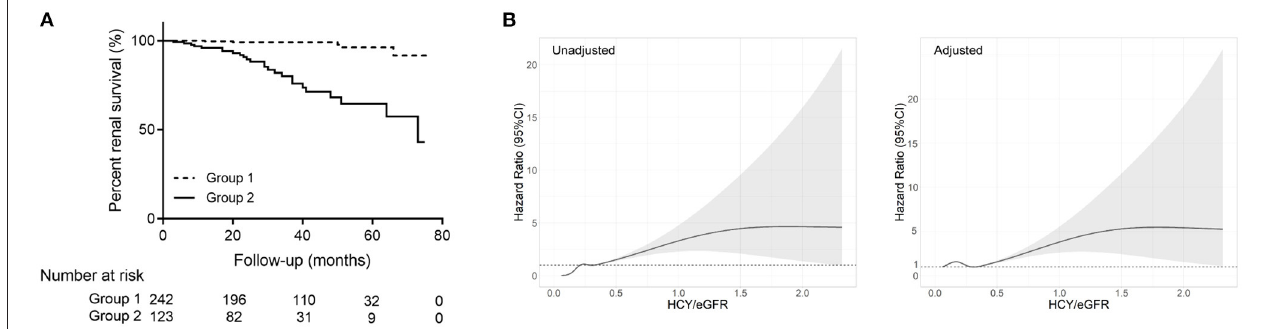
FIGURE 3 | Association of Hcy/eGFR ratio with kidney disease progression in IgAN. (A) Kaplan-Meier kidney survival curves of participants with IgAN according to Hcy/eGFR ratio. The time zero was kidney biopsy. The division between the groups of participants was on the basis of the cut-off value of Hcy/eGFR ratio (Group 1: low Hcy/eGFR ratio; Group 2: high Hcy/eGFR ratio). (B) Unadjusted and multivariable-adjusted hazard ratios for CKD progression events according to Hcy/eGFR ratio on a continuous scale. The solid lines represent the estimated hazard ratios, with the shaded areas showing 95% confidence intervals derived from restricted cubic spline regressions with five knots. Reference lines for no association are indicated by the dashed lines at a hazard ratio of 1.0. The model was adjusted for age, sex, eGFR, proteinuria, mean arterial pressure, and use of steroids and/or other immunosuppressive